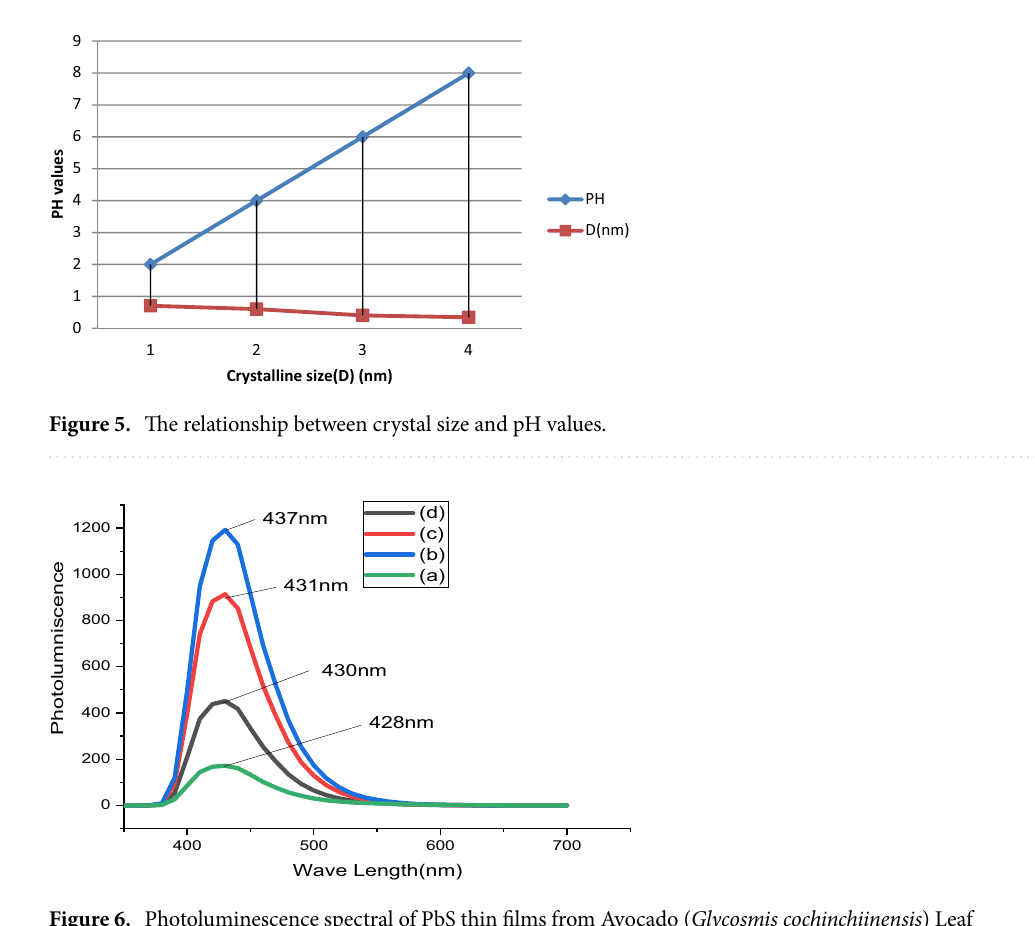
Figure 6. Photoluminescence spectral of PbS thin films from Avocado ( Glycosmis cochinchiinensis ) Leaf extracts at different pH values varied as ( a ) 2, ( b ) 4, ( c ) 6 and ( d )